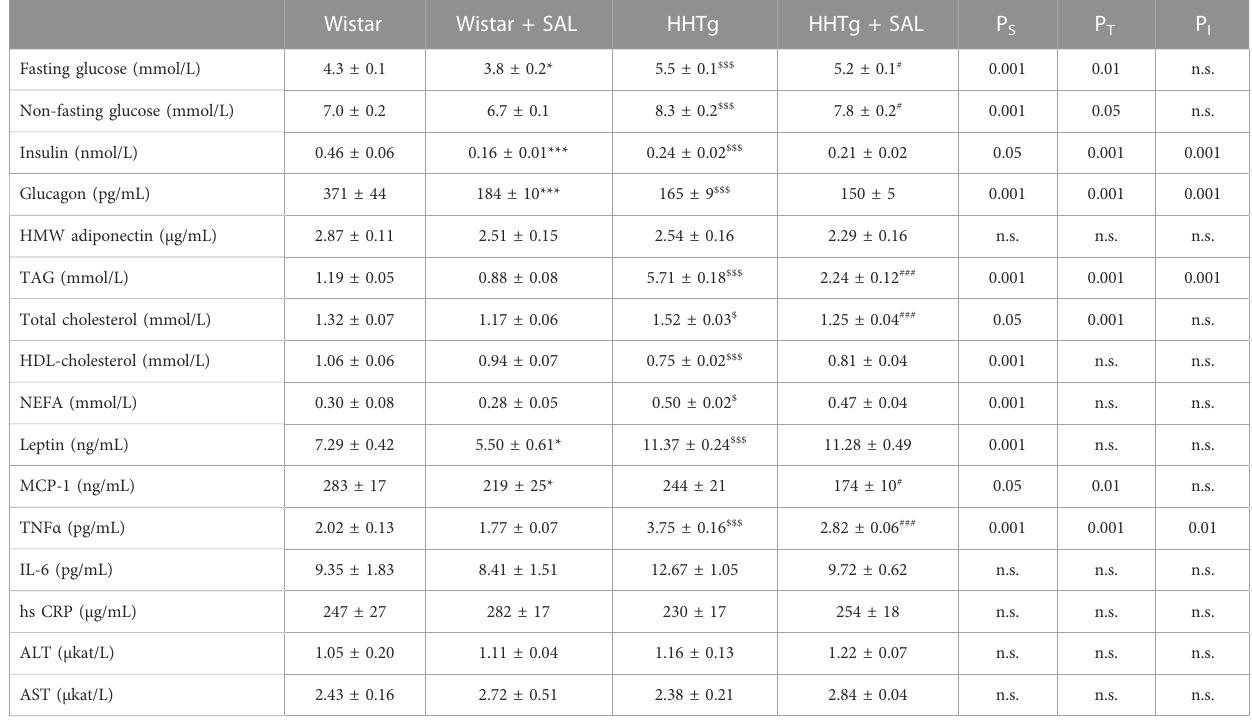
TABLE 1 Effect of salsalate treatment on serum parameters in Wistar control and prediabetic HHTg rats. Wistar Wistar + SAL HHTg